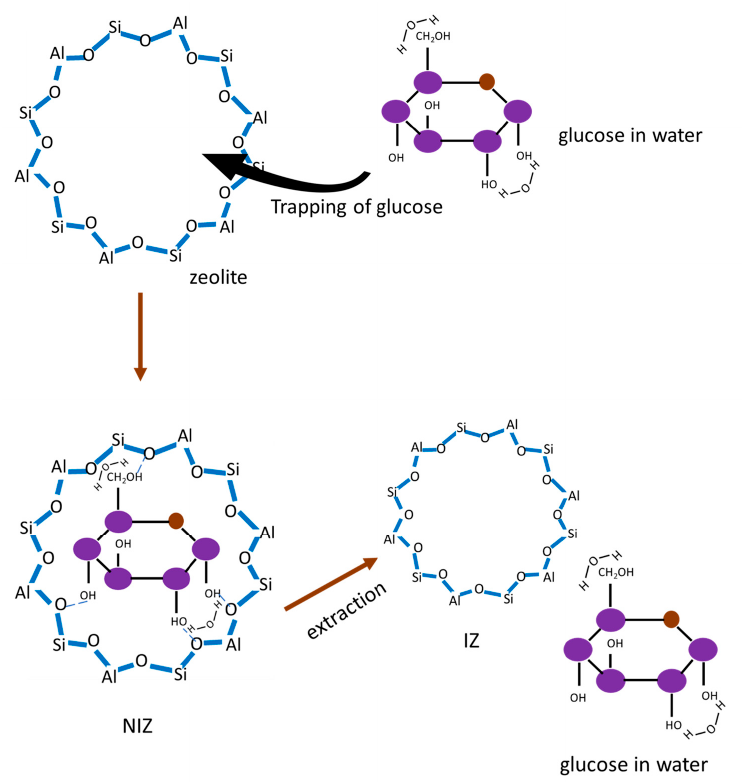
Figure 6. Illustration of the formation process of IZ.